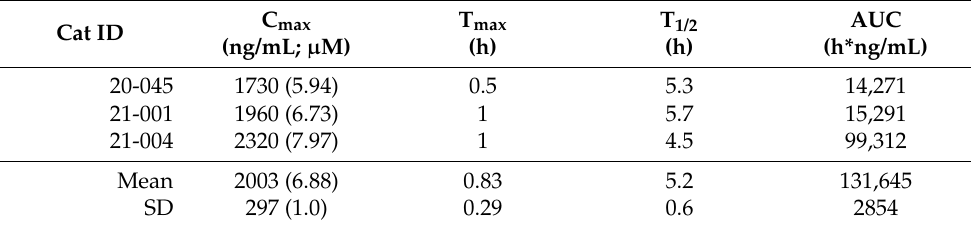
Table 5. Pharmacokinetic parameters for GS-441524 after a single IV dose of RDV (7 mg/kg) in 3